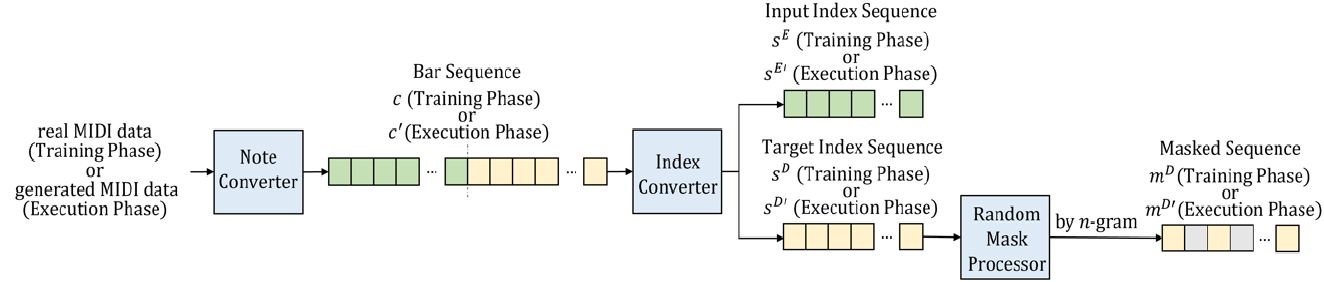
Figure 3. Preprocessor of the enhanced evaluation method, which consists of the note converter, index converter, and random mask processor.